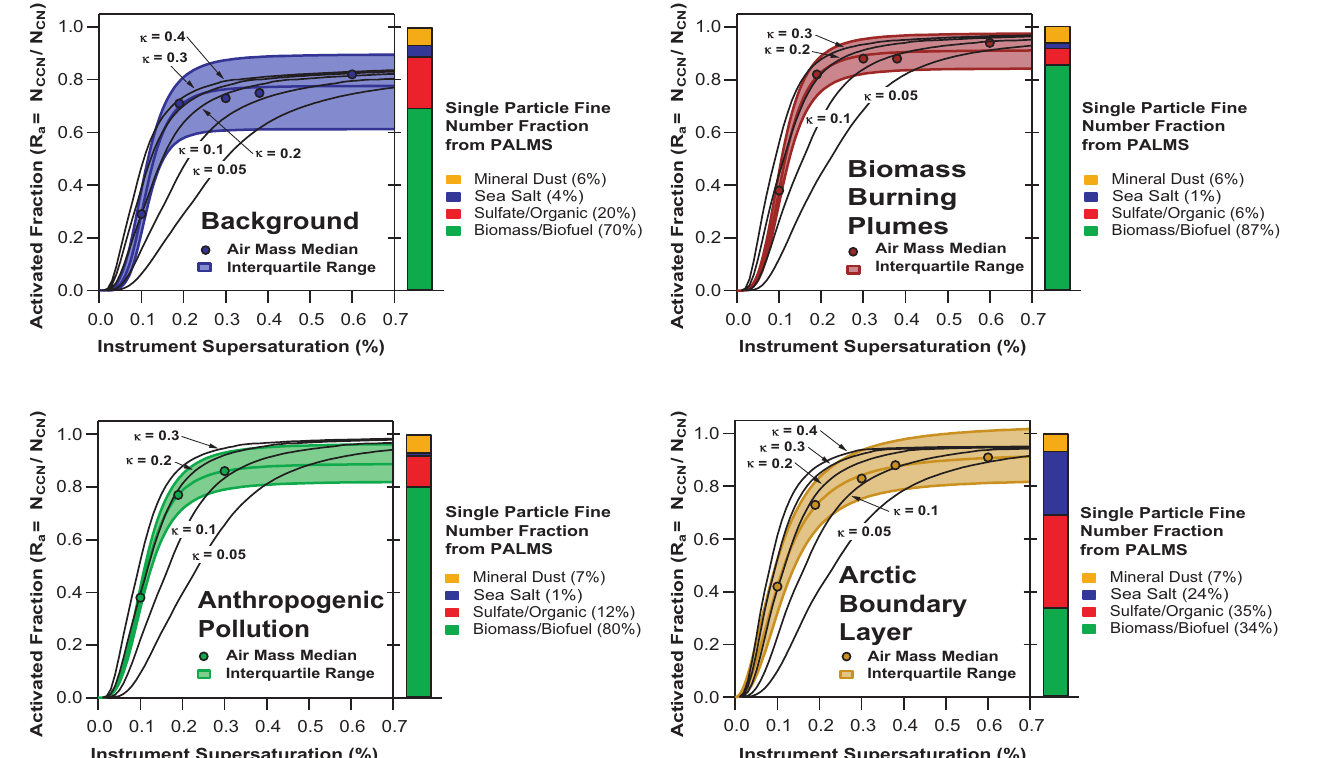
Fig. 5. Median CCN activated fraction ( R a = N CCN /N CN ) as a function of instrument supersaturation for each air mass sampled during 12–21 April. Thick, colored curves are sigmoidal fits of the form R a = a 0 /( 1 + (s/a 1 ) − a 3 ) , where a 0 , a 1 , and a 2 are fitting constants, and the shaded region in the figure is the interquartile range. Thin, black lines denote constant values of the hygroscopicity parameter, κ , computed based on the average size distribution for each air mass type. The stacked bars show the number fraction of each particle type from the PALMS instrument for particle diameters of 150-750 nm.